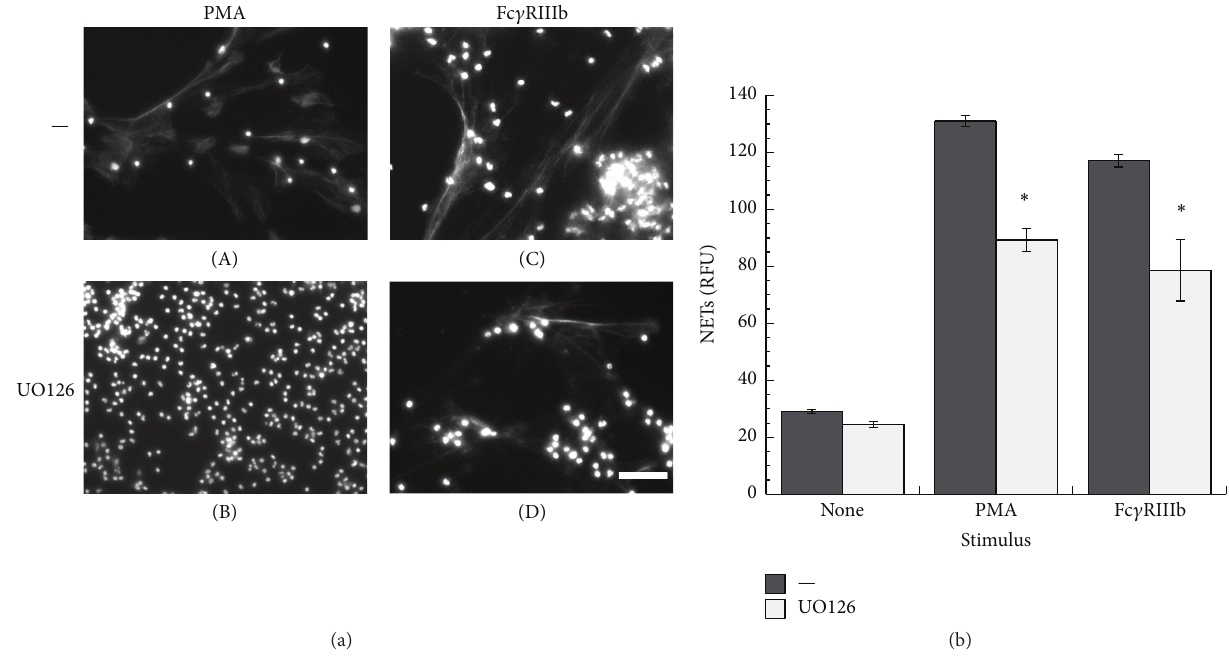
Figure 5: Fc 𝛾 RIIIb-induced NET formation is dependent on MEK. (a) Human neutrophils (PMN) were not stimulated (None) or were stimulated with 20 nM phorbol 12-myristate 13-acetate (PMA) or by cross-linking Fc 𝛾 RIIIb with mAb 3G8. PMN were previously treated with solvent alone (—) or with the MEK inhibitor UO126 (50 𝜇 M). After four hours, PMN were fixed and stained for DNA (DAPI). Microphotographs were taken at 200x magnification and are representative of five experiments. Bar is 50 𝜇 m. (b) The relative amount of NETs was estimated from SYTOX Green fluorescence in relative fluorescent units (RFU) at 4 hours after stimulation. Data are mean ± SEM of 8 experiments. Asterisks denote conditions that are statistically different from control ( 𝑝 < 0.001